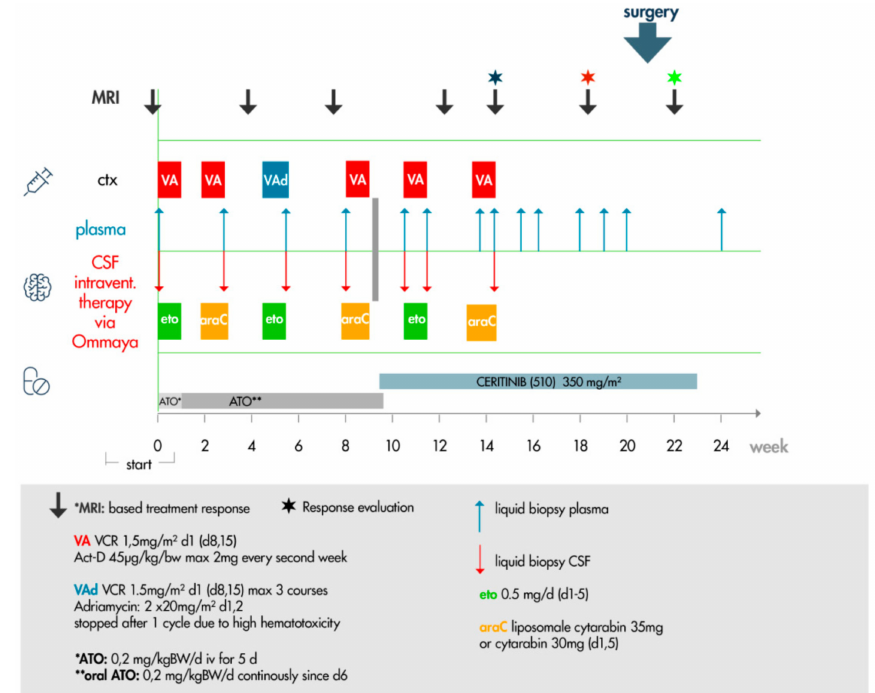
Figure 6. Personalized therapy protocol. Chemotherapy incorporated systemic (ctx) VA (vincristine and actinomycin-D, red) and VAd (adriamycin, blue) blocks, and intraventricular (via Ommaya) cytarabine (araC, yellow) and etoposide-Gry (eto, green). ATO was administered to coincide with the chemotherapy backbone as an intravenous (iv) treatment for 1 week (bright grey), and was subsequently switched to an oral ATO formulation (dark grey). The duration of ATO treatment lasted 68 days (9.7 weeks) in total. Ceritinib was given for 93 days. A metastatic lesion in the cerebellum was detected by MRI after 30 days of ceritinib treatment in combination with VA and intraventricular therapy (blue star). After 30 days of ceritinib monotherapy following the detection of the metastatic relapse, a response to the treatment was confirmed by MRI (red star). Surgical removal of the sanguineous necrotic area was performed (big blue arrow). A third relapse was detected by MRI (green star) two weeks after the detection of the response. The patient died 27 months after initial diagnosis and 3.5 months after the third